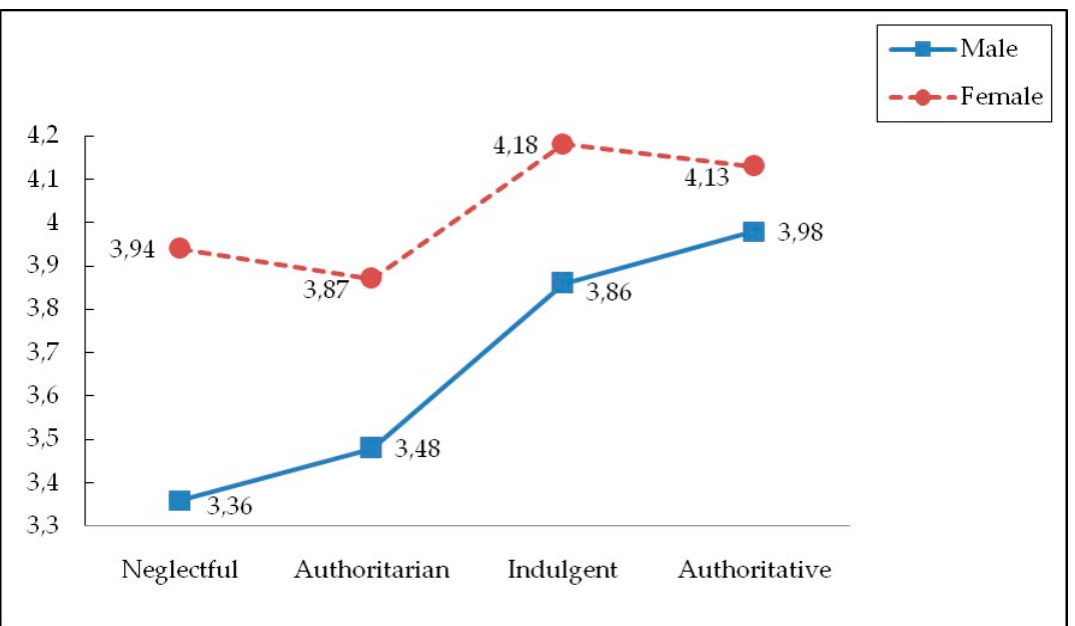
ff ect parenting styles x gender and emotional empathy to natural Figure 1. Interaction effect parenting styles x gender and emotional empathy to natural environment. Figure 1. Interaction e